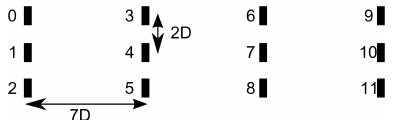
Figure 10. Layout and numbering of turbines in a turbine array case for both SOWFA and